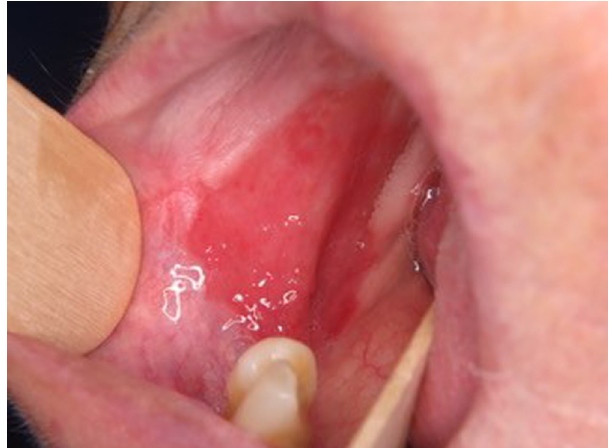
Fig. 5. Erythroplakia of the right buccal mucosa (image provided by University of Bordeaux).